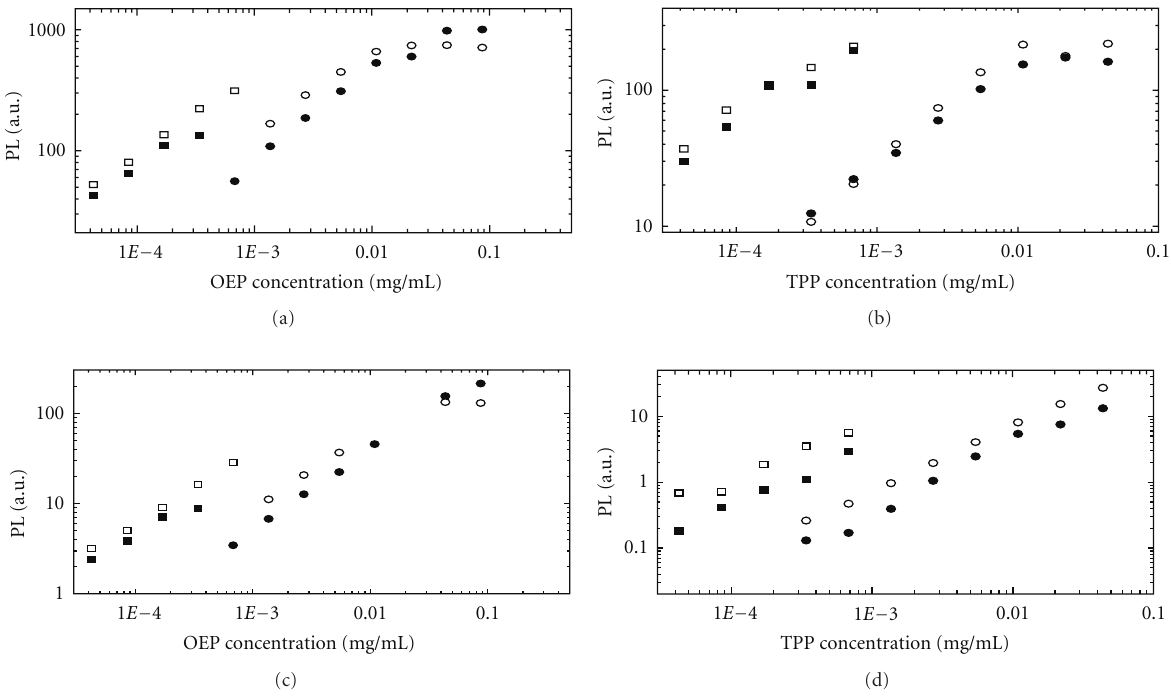
Figure 4: PL intensity as a function of concentration for 5:1 porphyrin:SWNT solutions for OEP (a, c) and TPP (b, d) show enhanced luminescence for composites. These solutions were photoexcited at the Soret band (a, b) (396 nm and 417 nm for OEP and TPP, resp.) and Q band (c, d) (529nm and 590 nm for OEP and TPP, resp.) wavelengths. Measurements were performed in 2 mm quartz cuvettes for concentrations higher than 0.0003 mg/mL. A 1 cm quartz cuvette was used for all other measurements. Im { χ (3) } = n 02 ε 0 c λβ I / 2 π , where n 0 is the linear